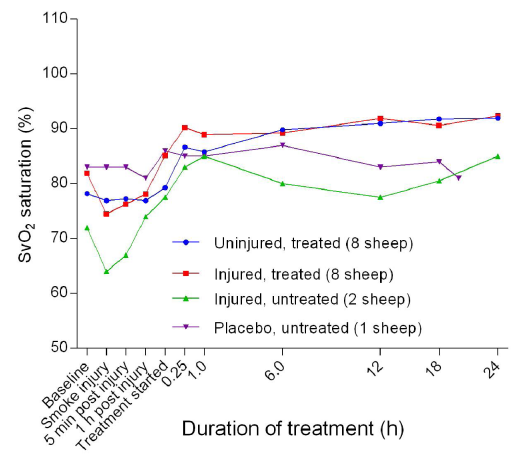
Figure 26. Mixed venous oxygen saturation (SvO error bars not shown) in smoke and non-smoke injured sheep that received extracorporeal life support as compared to that in untreated controls.